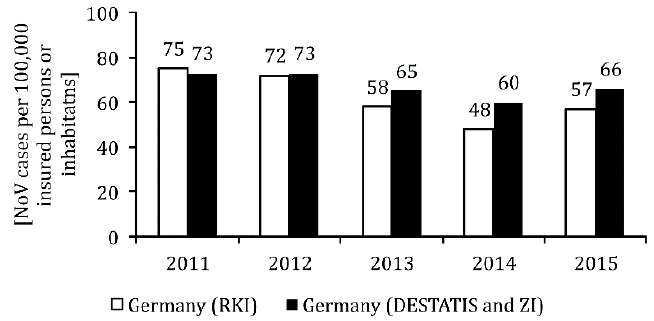
Figure 3. NoV incidence among 20 to 64 year olds (cases per 100,000 inhabitants) in the years 2011 to 2015 in Lower Saxony according to the reference definition ‘clinical laboratory diagnostic’ of the Robert Koch Institute (RKI) [7], as well as inpatient and outpatient NoV cases in the same age group in Germany as a whole according to data from the Central Institute for the Association of Statutory Health Insurance Physicians (ZI) and the Federal Statistical Office (DESTATIS).